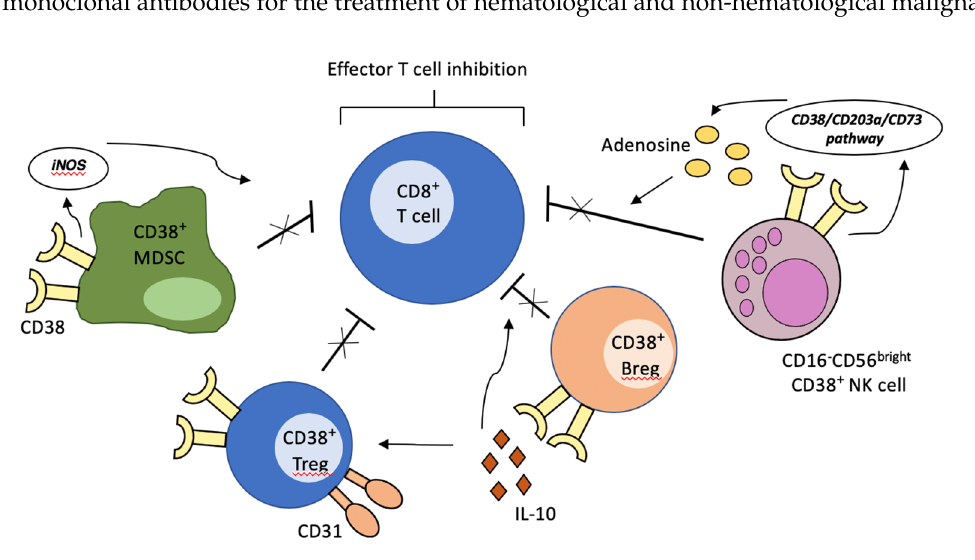
Figure 1. Creation of immunosuppressive microenvironment by CD38-expressing immune cells. The activation of CD38-mediated signaling pathways on regulatory T cells, regulatory B cells, MDSCs and specific NK cell subsets of the tumor microenvironment leads to inhibition of effector T-cell activity, thus contributing to immune escape.